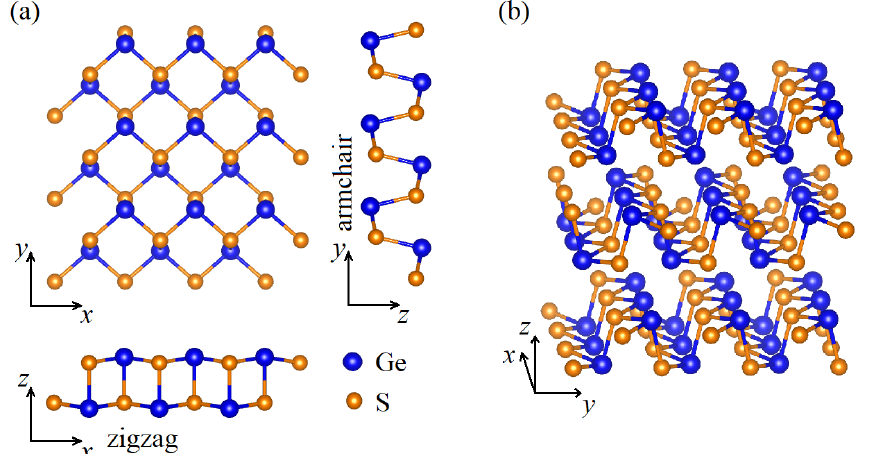
Figure 1. ( a ) Top and side views of the GeS crystal structure for a single layer. The armchair and zigzag directions are shown in relation to the crystal orientation and lattice parameters. ( b ) Geometrical structure of multilayer